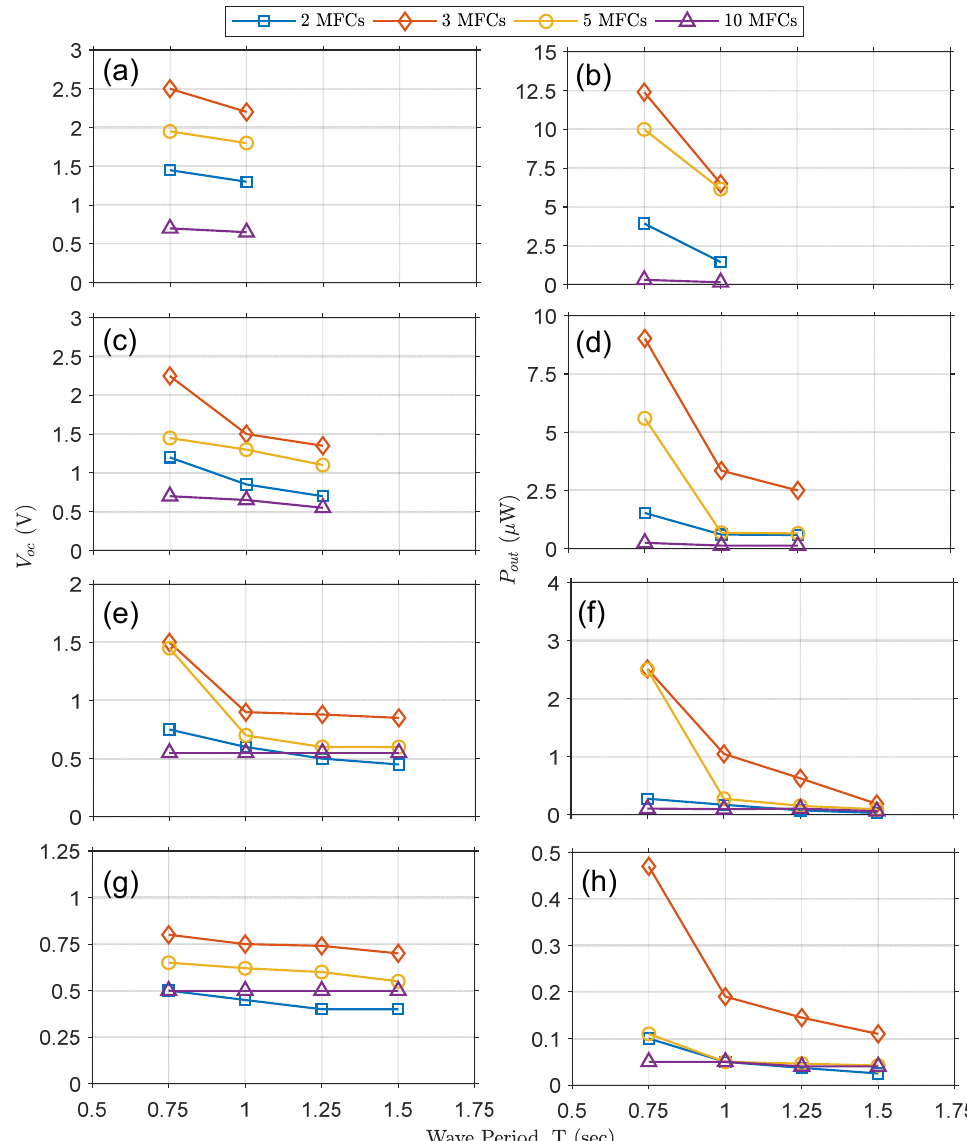
Figure 8. Graphs depicting V OC and P OUT as functions of wave period for a specific wave height and for OWECs with varying numbers of MFCs (2, 3, 5, and 10). ( a , b ) Output voltage and power for 20 cm nominal wave height and 0.75 and 1.00 s wave periods. ( c , d ) Output voltage and power for 15 cm nominal wave height and 0.75, 1.00, and 1.25 s wave periods. ( e , f ) Output voltage and power for 10 cm nominal wave height and 0.75, 1.00, 1.25 and 1.50 s wave periods. ( g , h ) Output voltage and power for 5 cm nominal wave height and 0.75, 1.00, 1.25 and 1.50 s wave periods.